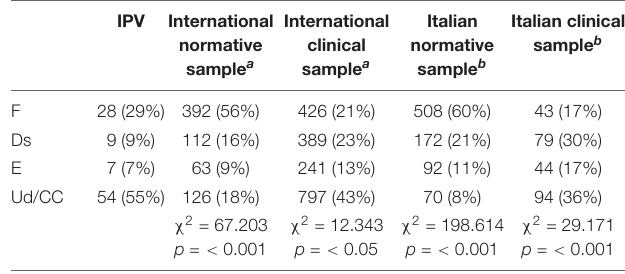
TABLE 6 | Comparison of AAI classifications obtained by the IPV group with those of normative and clinical samples.